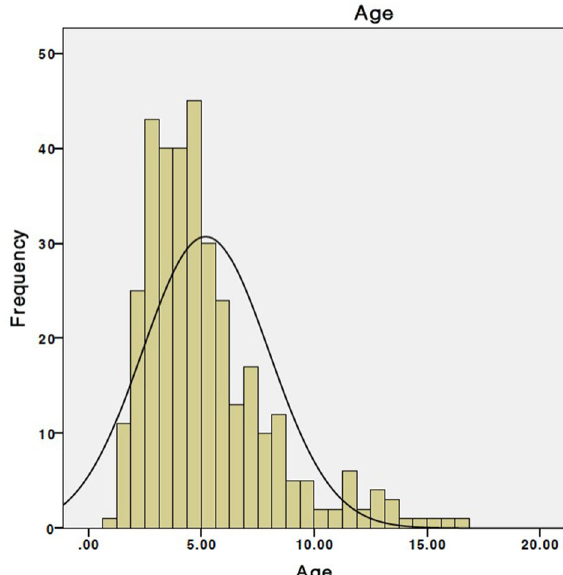
Figure 1. Age (years) distribution of the studied patients.